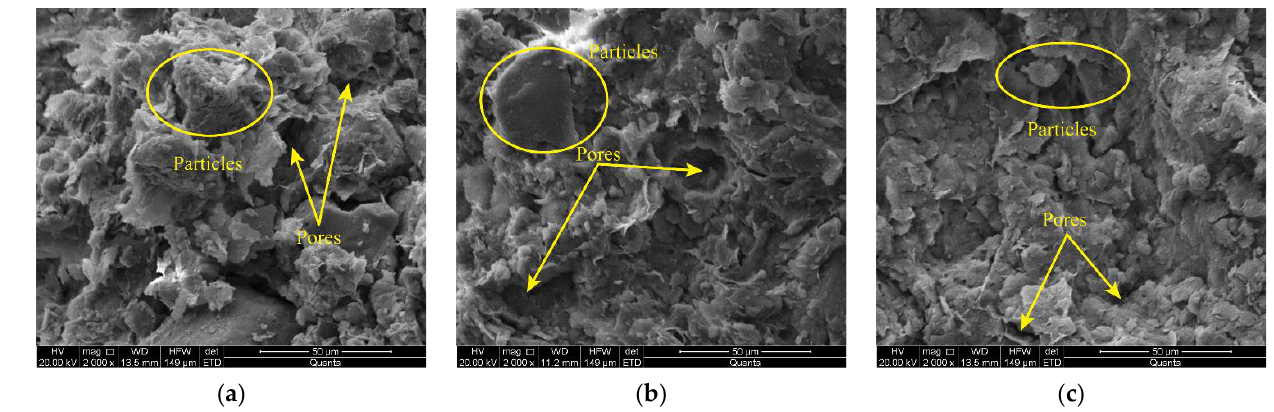
Figure 12. SEM results for clay: ( a , b ) outside the shear band; ( c ) inside the shear band.